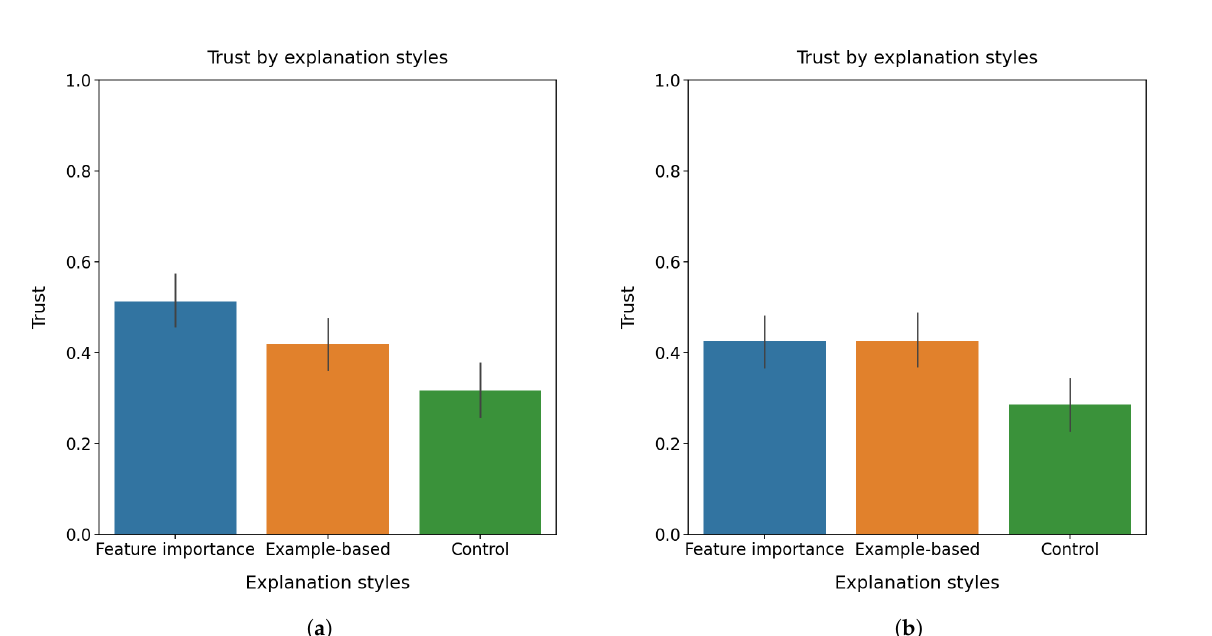
Figure 9. User trust over explanation types in two scenarios. ( a ) Health insurance decision-making. ( b ) Medical treatment decision-making.